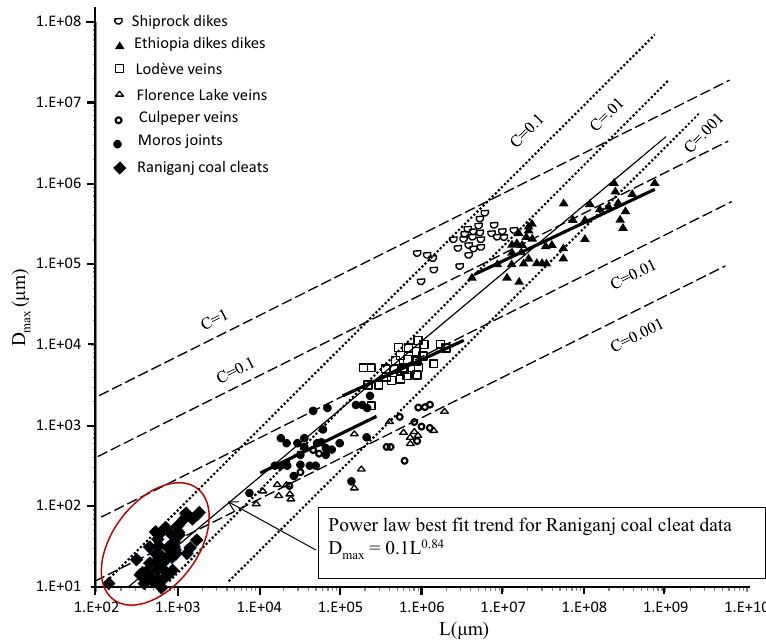
Fig. 9 Compilation of cleat length versus maximum aperture width ( D max ) for Raniganj coals (rectangular solid dots within the encircling ellipse) with equivalent data sets for opening mode joints, veins and dikes (see: Schultz et al. 2008a, b). Dotted and dashed lines represent different slopes (pre-exponential constant ‘c’) with constant values of n = 1 and n = 0.5 respectively. Darker lines show power-law fits to: Lode‘ve sparitic sinuous veins: D max = 0.01 L 0.47 , R 2 = 0.41; Moros joints: D max = 0.0025 L 0.48 , R 2 = 0.45; and Ethiopia dikes: D max - = 0.078 L 0.49 , R 2 =